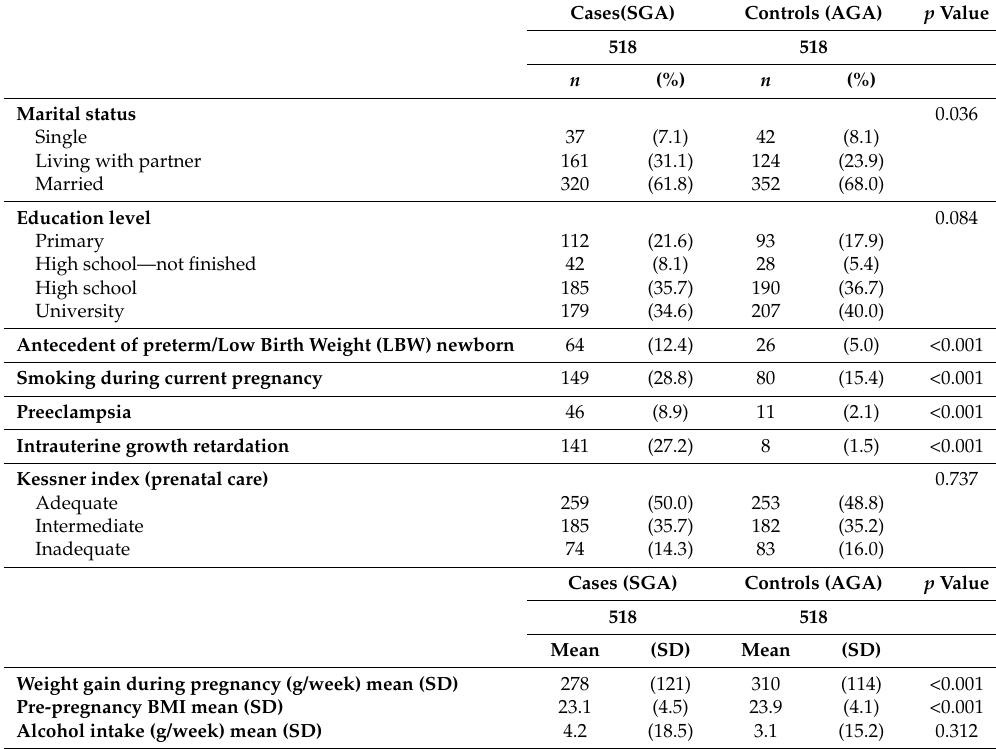
Table 1. Description of the study population among healthy pregnant Spanish women for AGA (Adequate for Gestational Age) and SGA ( n = 1036).